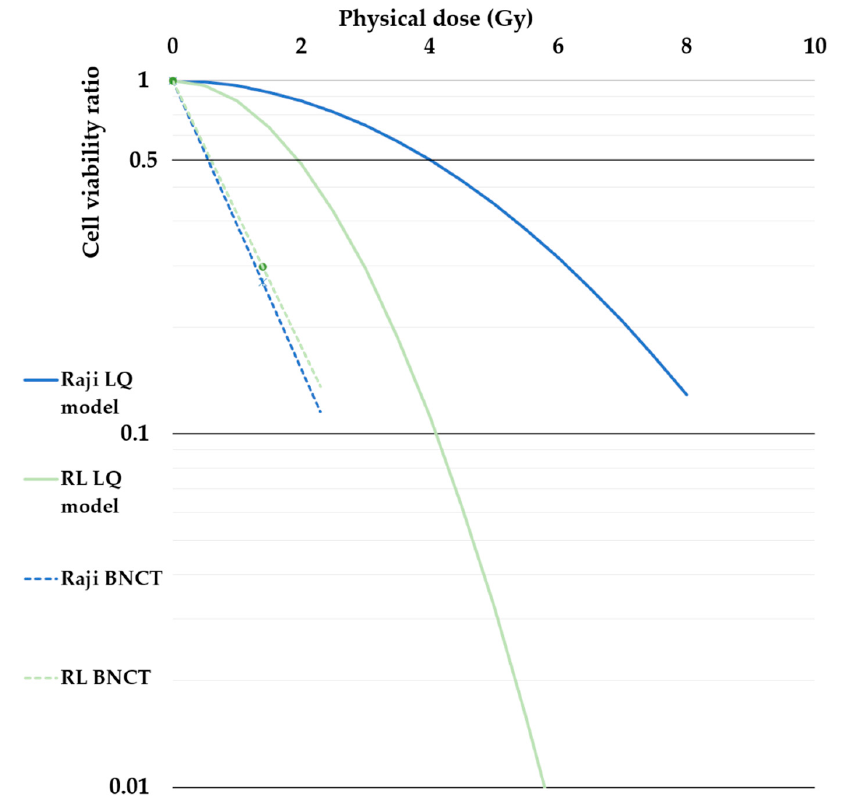
Figure A2. Cell viability ratio after neutron irradiation and photon irradiation fitted to the linear-quadratic (LQ) model for Raji and RL lymphoma cells. The physical doses required to achieve the same biological effects as the BNCT group 3 h after exposure to 5 μ g B/mL of Raji, RL were 4.6 and 2.3 Gy (cell viability ratio = 0.5). The physical doses for Raji and RL were 8.5 and 4.1 Gy when the cell viability ratio was 0.1. The CBE that could be calculated from the LQ model when cell viability ratio = 0.006 was equal to the CBE value (Raji = 10.6, RL = 5.6) calculated in this study (Raji = 9.5, RL = 3.4).